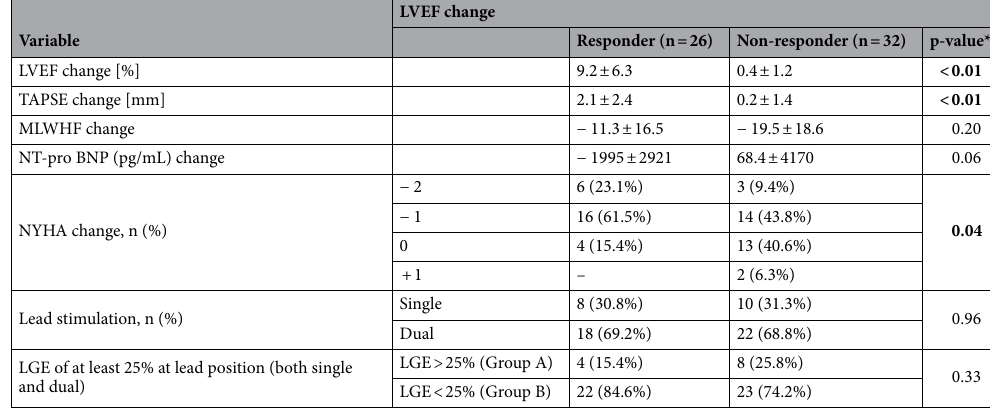
Table 3. Responder vs. non-responder based on LVEF change. LGE late gadolinium enhancement, NYHA New York Heart Association, FU follow-up. Values in bold are statistically significant. *Pearson Chi-square